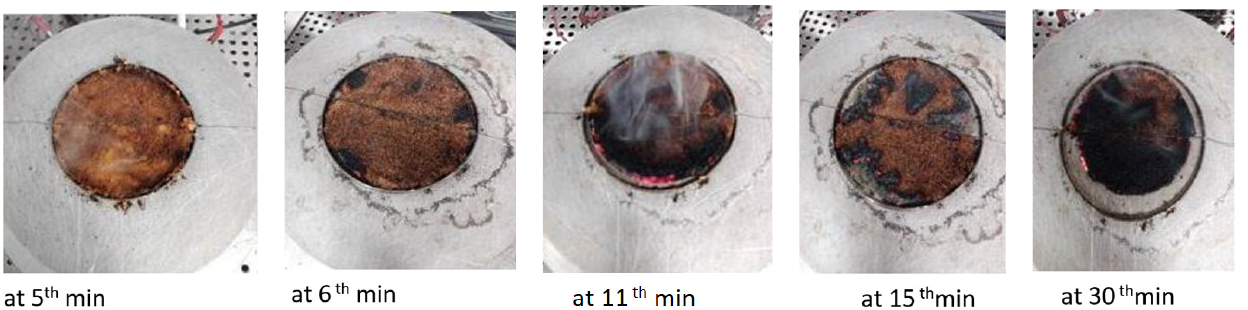
Figure 6. Smoldering nests around the perimeter of the sample WD_ExtrD caused by the ignition source, i.e., a hot surface.